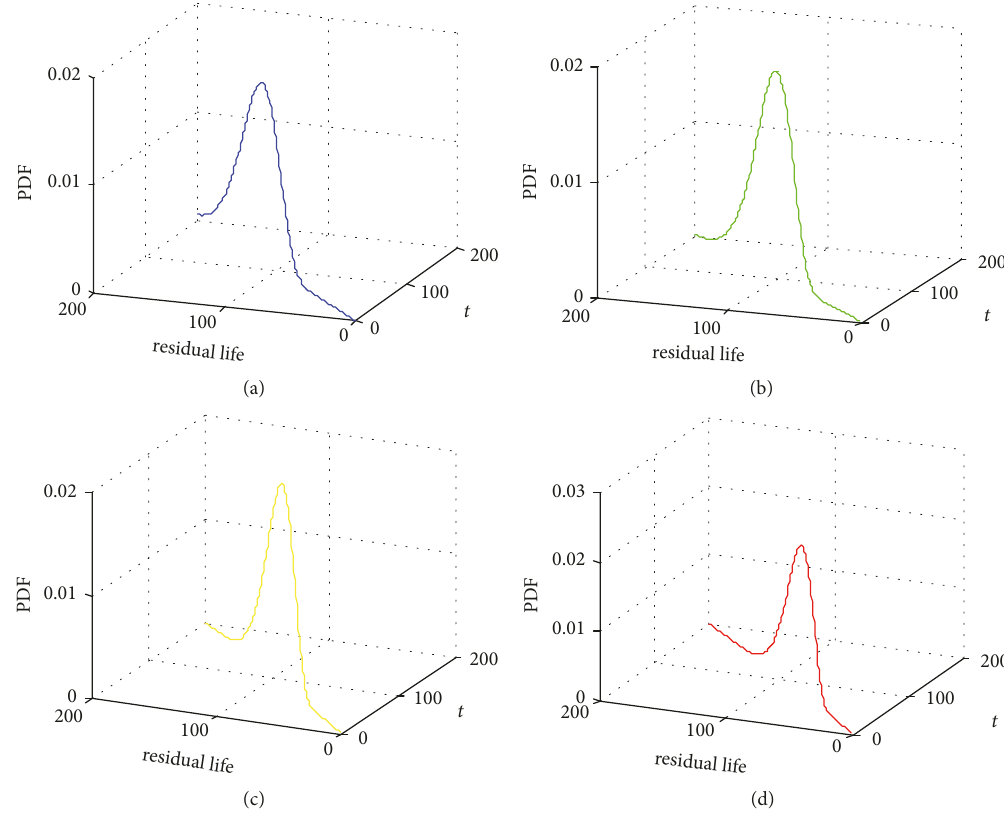
Figure 3: The degradation of 𝐾𝑜𝑥 of gyroscope.